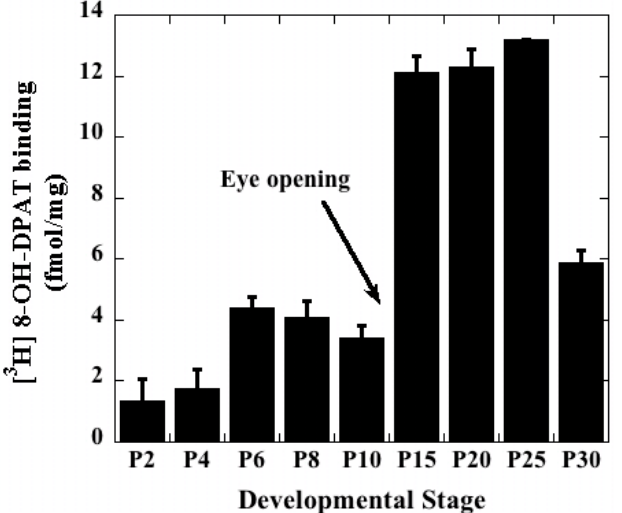
Figure 2. Developmental Profile of the G-protein-coupled form of the 5-HT 1A -R in the hippocampus. Hippocampi culled from each mouse were pooled and processed as one sample. [ 3 H] 8-OH-DPAT binding assay was conducted using 250 µg hippocampal membrane protein per tube for each developmental stage. Membrane samples were analyzed in triplicate tubes and the experiment was conducted on three mice ( n = 3) for each developmental time point. Data obtained were plotted with standard deviations. The sharp increases between P4 and P6 as well as between P10 and P15 were statistically significant ( t -test; p < 0.05).